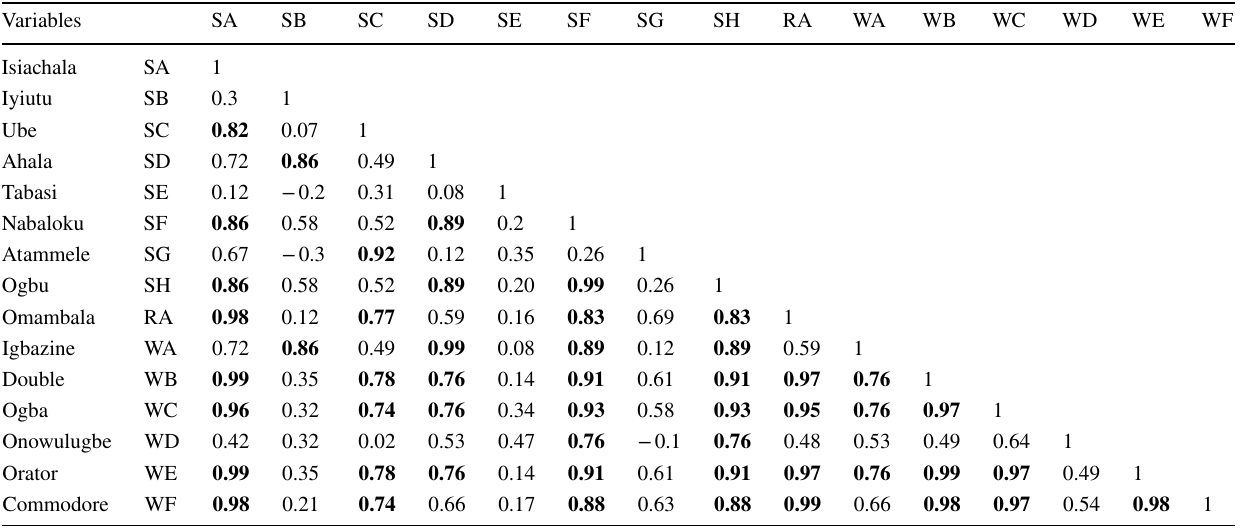
Table 5 Pearson correlation matrices of sample locations